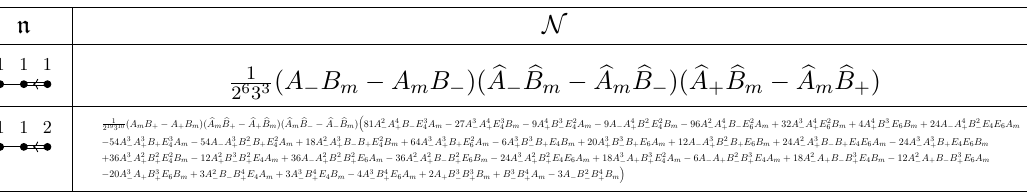
Table 11 . Elliptic genera of ( C 3 ) 0 . Here, A z = A z ( τ ) , b A z = A z (2 τ ) , and same for B z . n